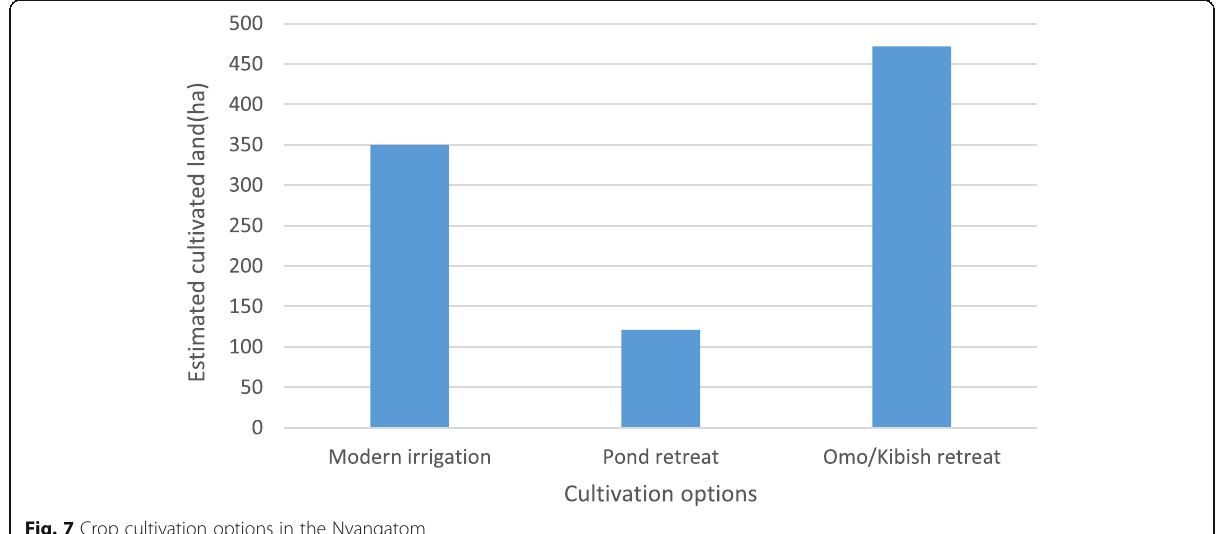
Fig. 7 Crop cultivation options in the